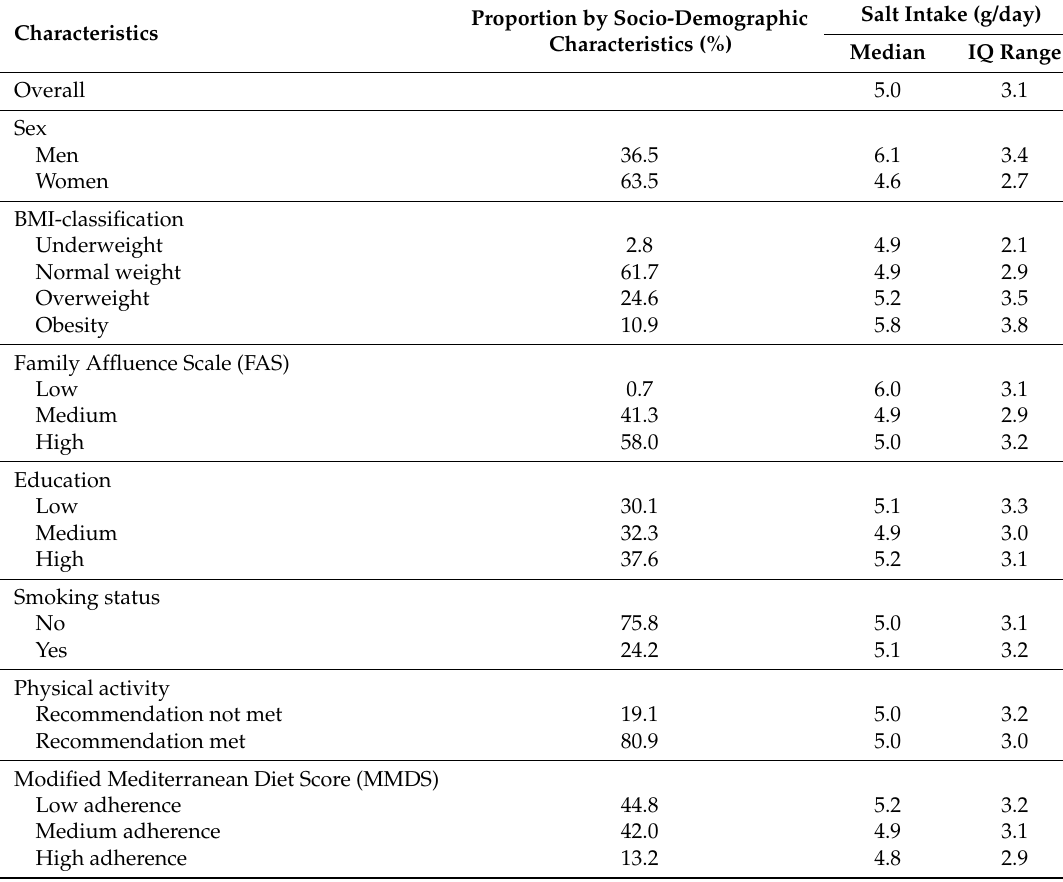
Table 3. Socio-demographic characteristics and dietary salt